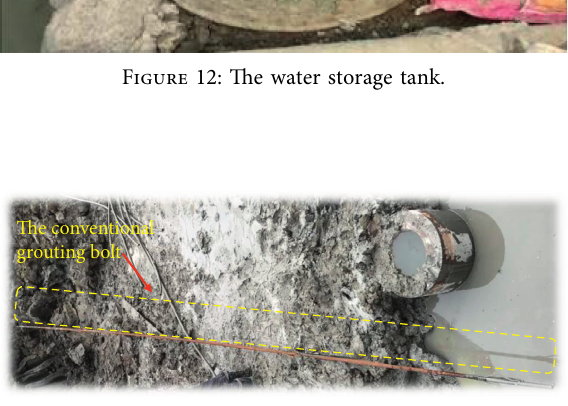
Figure 13: The conventional grouting